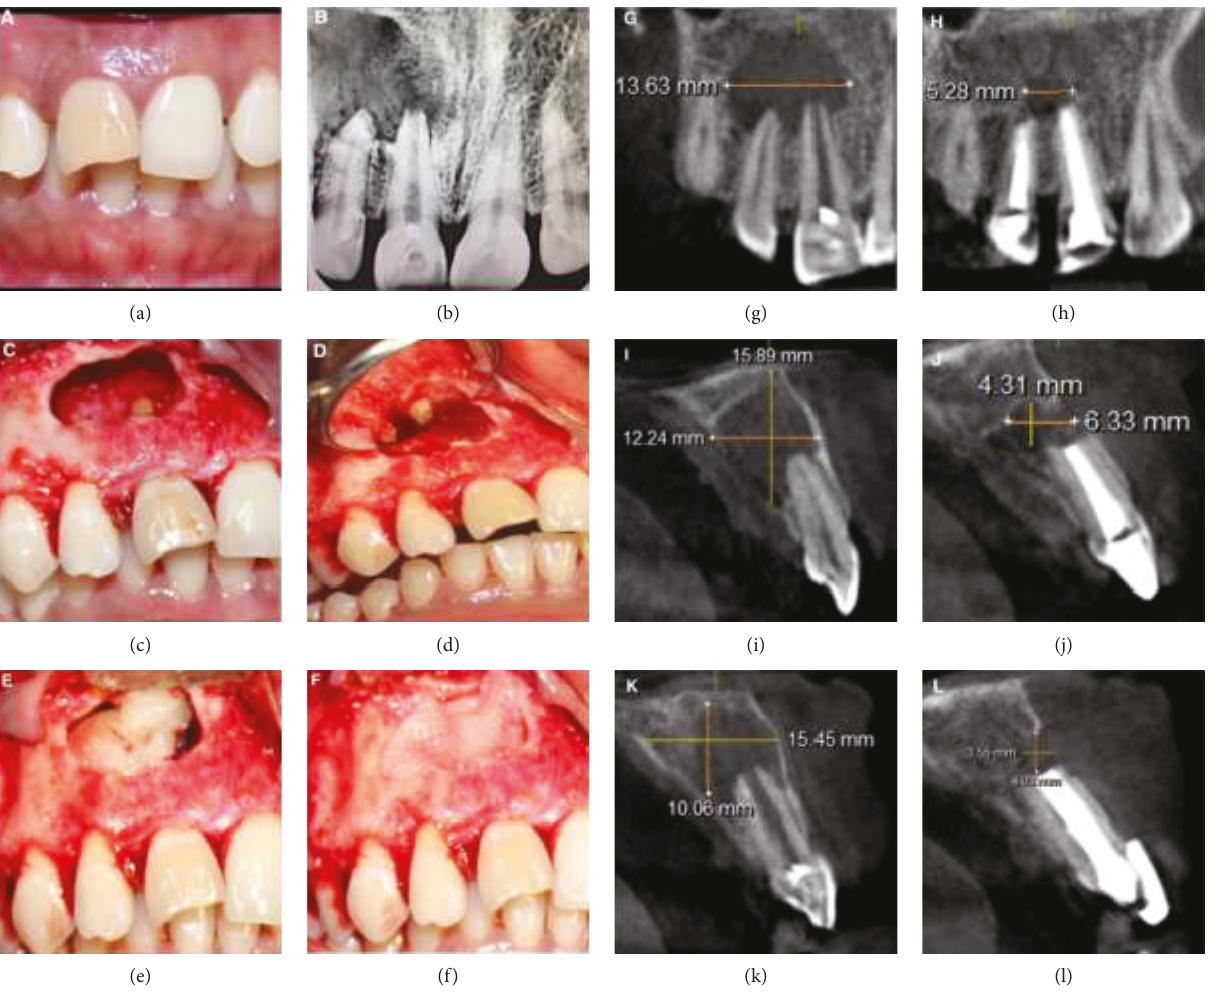
Figure 1: Preoperative clinical and surgical procedure and radiographic images: IOPA and CBCT images (Case Report 1). (a) Pre-op clinical photograph showing discoloured 11 with chipping of the incisal edge of the crown. (b) Preoperative IOPA showing the periapical lesion involving the apices of 11 and 12 and extending to the mesial margin of 13. (c) Complete curettage of the lesion and apicectomy done in 12. (d) Retrograde preparation and fi lling with MTA in 11 and 12. (e) CGF fi brin block placed in the bony cavity. (f) CGF membrane placed to cover the bone defect. (g) Pre-op CBCT image showing the lesion measurement in the coronal slice. (h) Post-op CBCT image showing the lesion measurement in the coronal slice. (i) Pre-op CBCT image showing the lesion measurement in sagittal slice corresponding to 12. (j) Post-op CBCT image showing the lesion measurement in sagittal slice corresponding to 12. (k) Pre-op CBCT image showing the lesion measurement in sagittal slice corresponding to 11. (l) Post-op CBCT image showing the lesion measurement in sagittal slice corresponding to